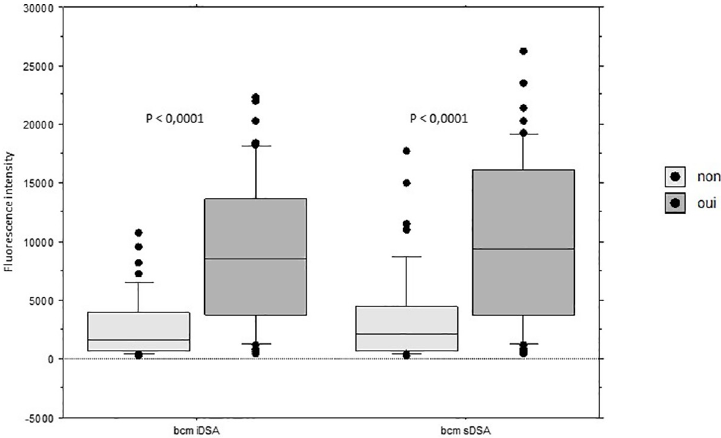
Fig 7. Intensity (BCM) of iDSA and sDSA according to the C3d-fixing DSA status. dnDSA: de novo DSA; iDSA: immunodominant DSA; sDSA: sum of the DSA. In all the box plots, the top of the box represents the 75th percentile, the bottom of the box represents the 25th percentile, and the middle line represents the 50th percentile. The whiskers represent the highest and the lowest values that are not outliers or extreme values. Black dots represent outliers.